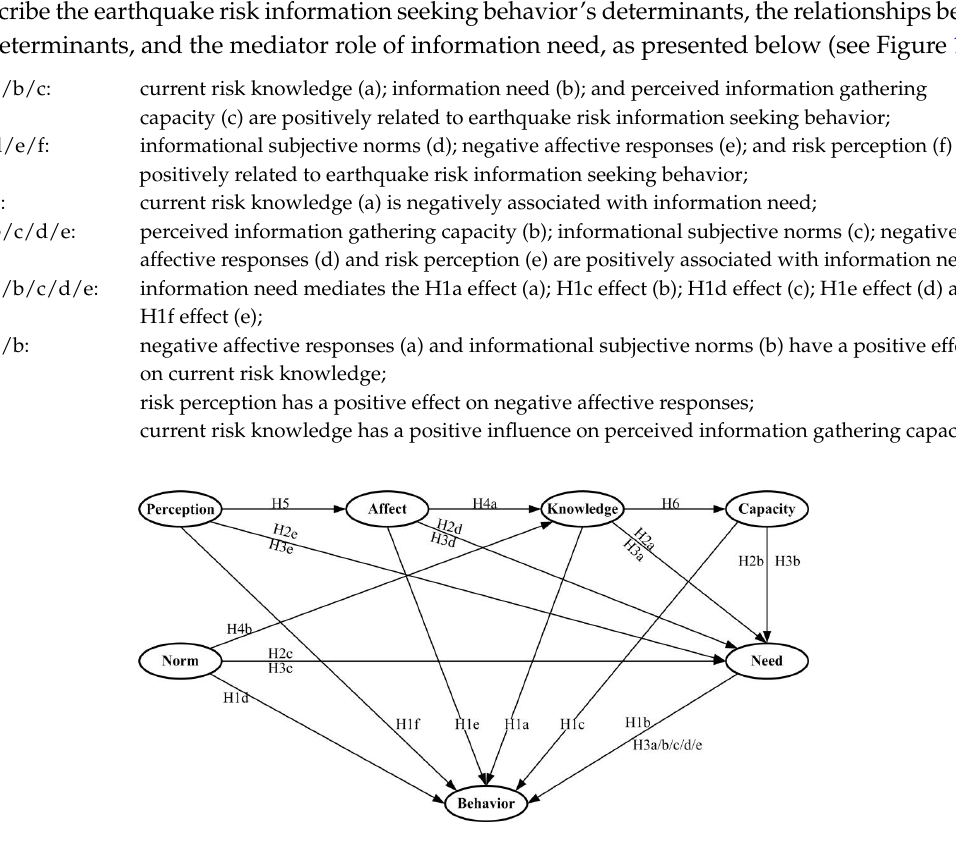
Figure 1. Hypothesized relationships among determinants of information seeking behavior. Behavior: Information seeking behavior; Knowledge: Current risk knowledge; Need: Information need; Capacity: Perceived information gathering capacity; Norm: Informational subjective norms; Affect: Negative affective responses; Perception: Risk perception.